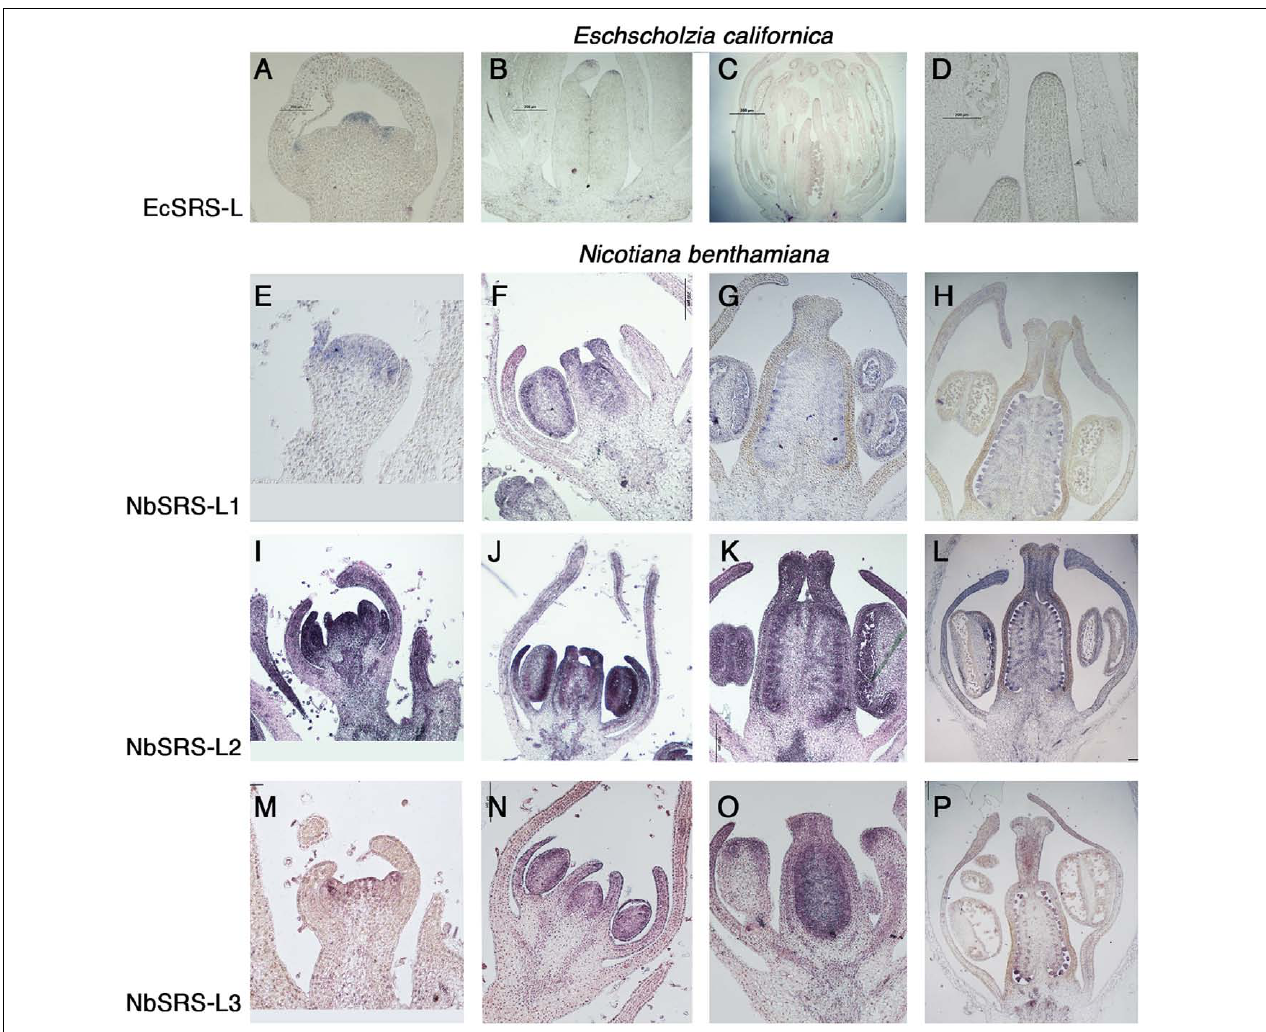
FIGURE 2 | In situ expression analyses of SRS-L genes in E. californica , and N. benthamiana flowers . Control hybridizations with sense probes are shown in Supplementary Figure S2 . (A–D) Longitudinal sections of E. californica flowers probed with EcSRS-L . (A) At stage 3, EcSRS-L mRNA is detected in a few cells at the tip of the incipient pistil primordium and of sepal and petal primordia. (B) At stage 6, expression in the gynoecium is restricted to the most apical cells of the incipient style. (C) Later in development, expression of EcSRS-L is detected in ovule primordia, the anthers and in the most apical cells of the developing style. (D) Close up of the apical style shown in (C) . (E–P) Longitudinal sections of N. benthamiana flowers probed with NbSRS-L genes (E–H) , NbSRS-L2 (I–L) and NbSRS-L3 (M–P) . The three genes show remarkably similar expression patterns, although NbSRS-L2 appears to be expressed at higher levels. (E–H) NbSRS-L1 mRNA is detected in the floral primordium at very early stages (E) , and later it accumulates in the anthers, the developing placenta and the distal end of petals and carpels (F) . (G,H) After all floral organs differentiate, NbSRS-L1 is mainly detected in ovule primordia, the style, the anthers and the distal end of growing petals. (I,J) NbSRS-L2 is strongly expressed throughout flower development, mainly accumulating in distal positions in floral organs, placenta, ovules, anthers and the style. (M,N) The expression pattern of NbSRS-L3 is very similar to that of NbSRS-L1 , although the expression in the style appears stronger at later stages (O,P) .